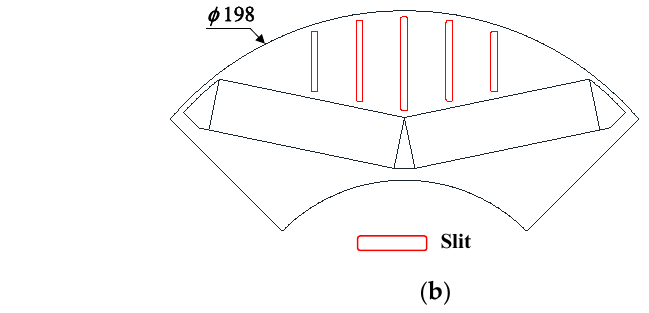
Figure 5. Proposed design in the rotor shape: ( a ) eccentricity, and ( b ) slit.